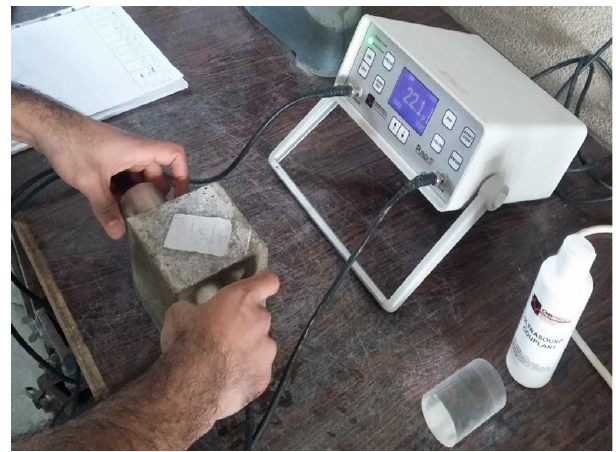
Materials 2021 , 14 , x FOR PEER REVIEW